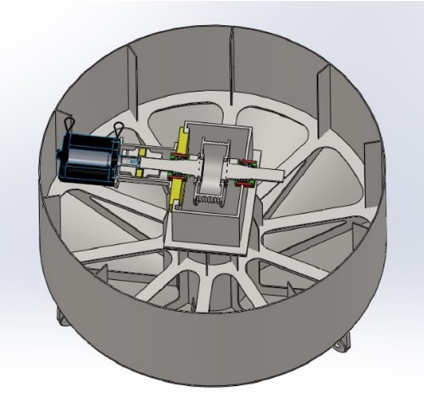
Figure 14. PTO and hull feasibility analysis.